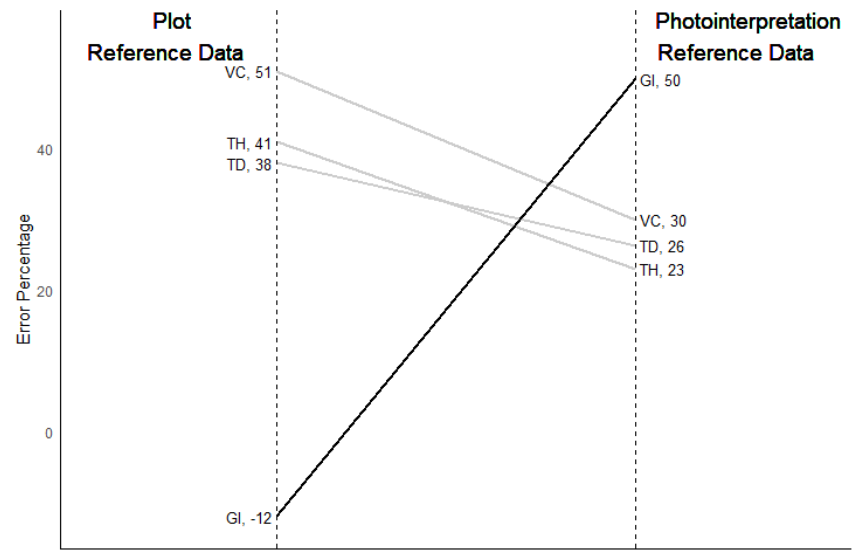
Figure A3. RPA results’ Error Percentage inside field plots when considering two reference data: photointerpretation and fieldwork.